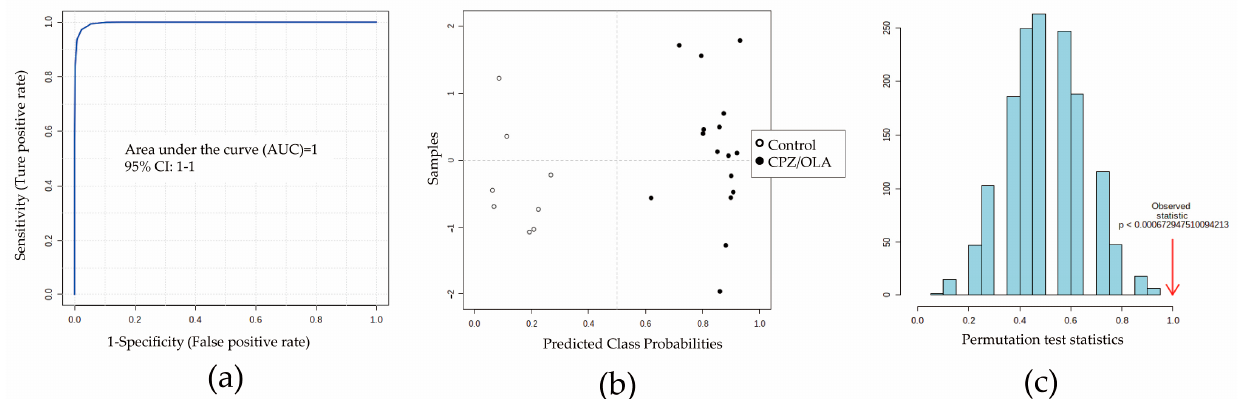
Figure 3. Evaluation of potential combinations of metabolites by a training set. ( a ) The area under the ROC curve (AUC) for prediction performance was 1 (95%CI of AUC: 1–1). ( b ) Predicted class probabilities between CPZ/OLA fatal intoxications (high dose) and controls. ( c ) Permutation tests showing the DCM to be outside the distribution of random class assignments based on each respective between-group sum of the squares and within-group sum of squares (B/W) ratio ( p < 0.05). n = 8.